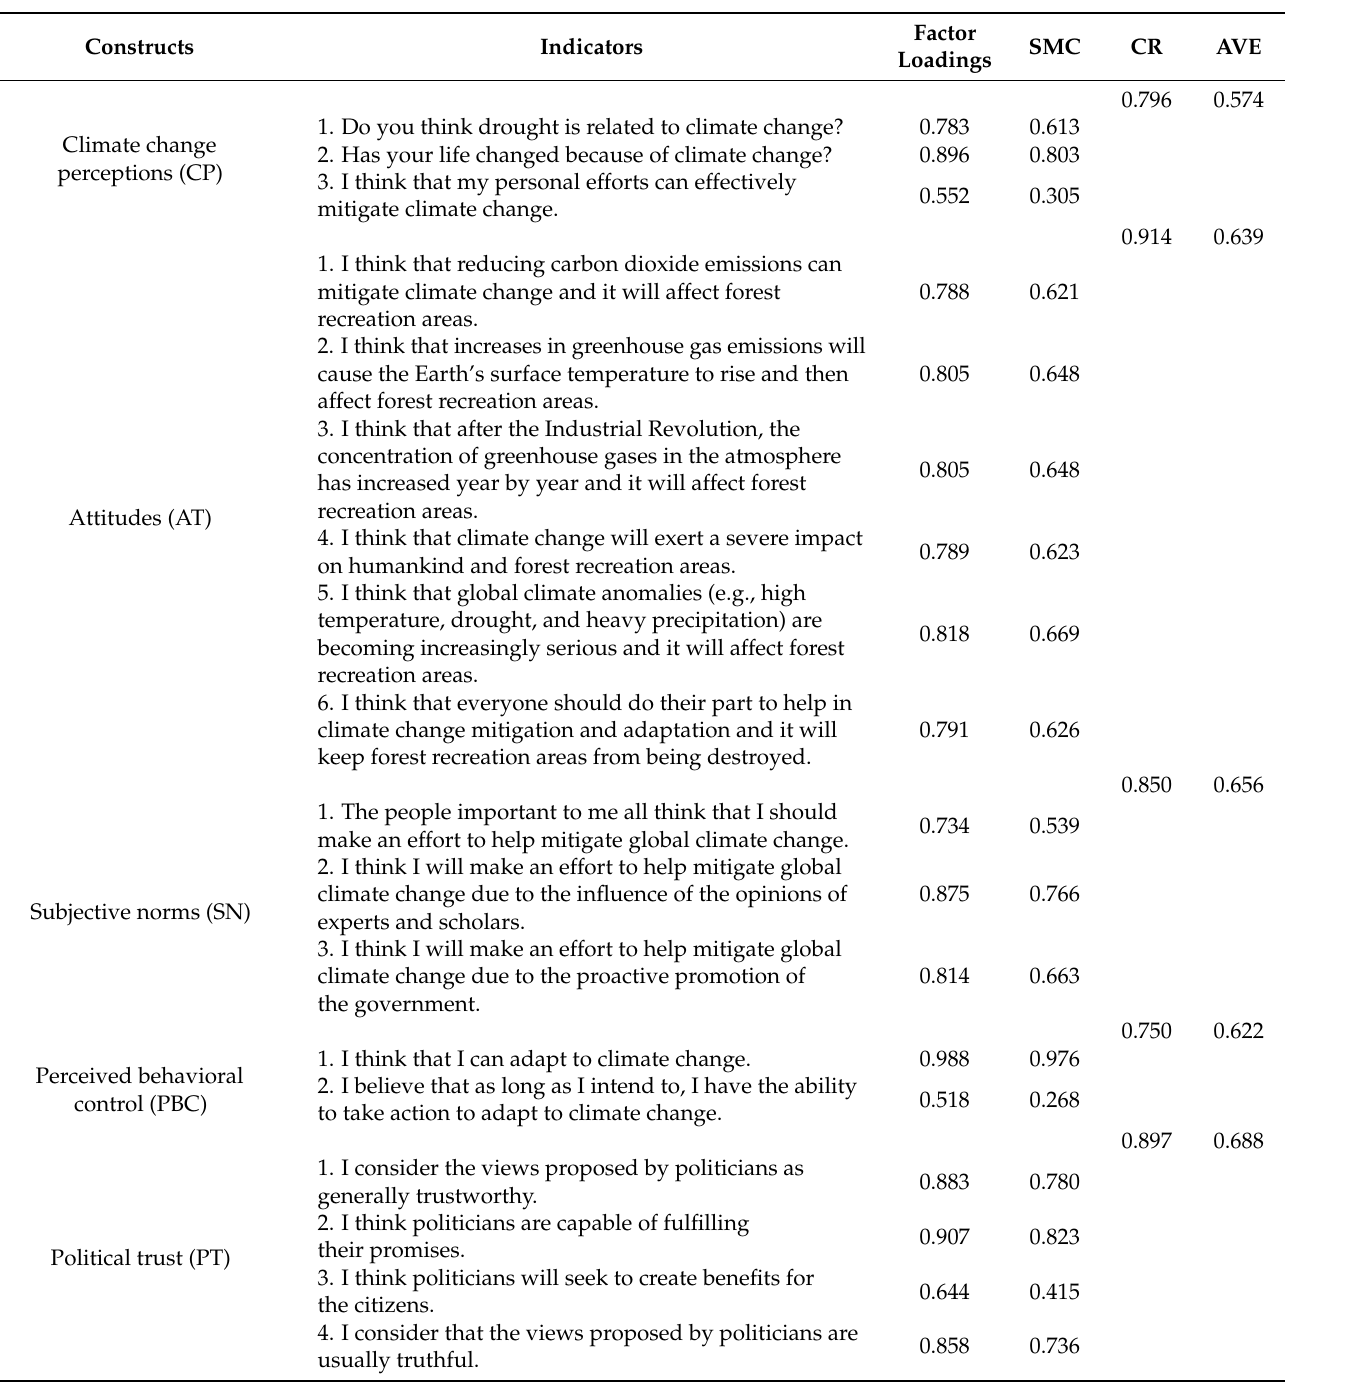
Table 2. Reliability and validity